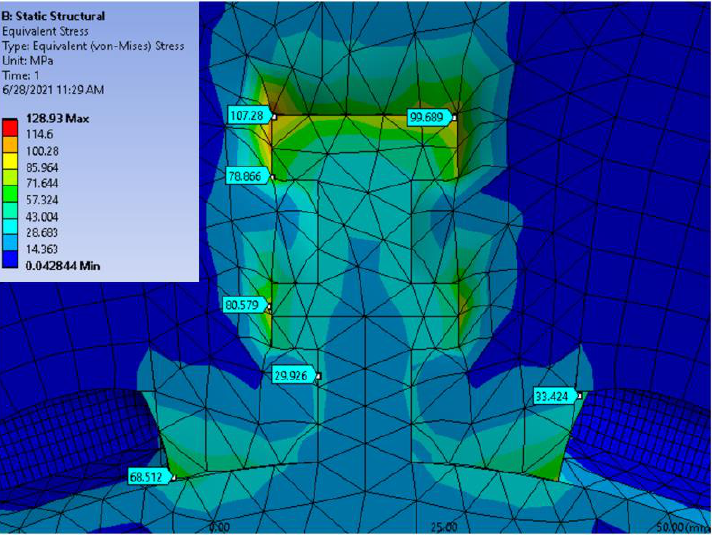
Figure 15. Mechanical analysis of the proposed 6Φ -S-FSCW-Fer-SPMSM at 3750